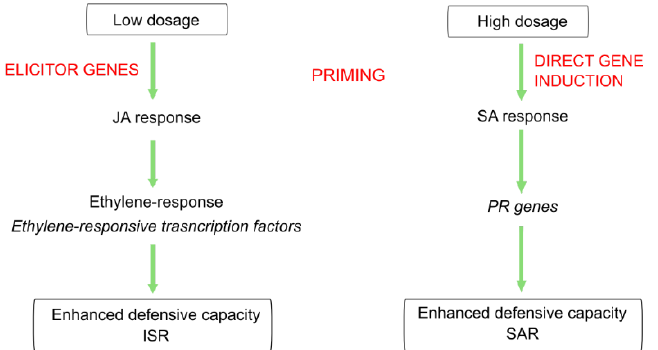
Figure 9. Summary of the hypothesized role of different dosages of ELICE16INDURES during two induced resistance mechanisms.